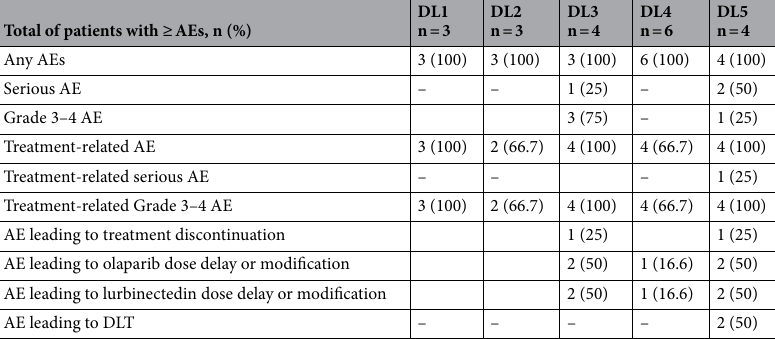
Table 2. Overview of safety. AE adverse event, DL dose level, DLT dose limiting